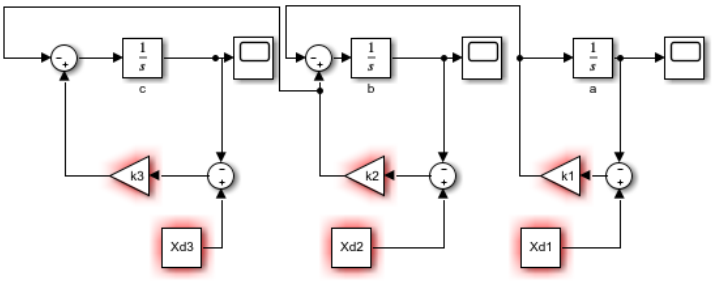
Figure 15. Block diagram of n = 3 ironing state variables.